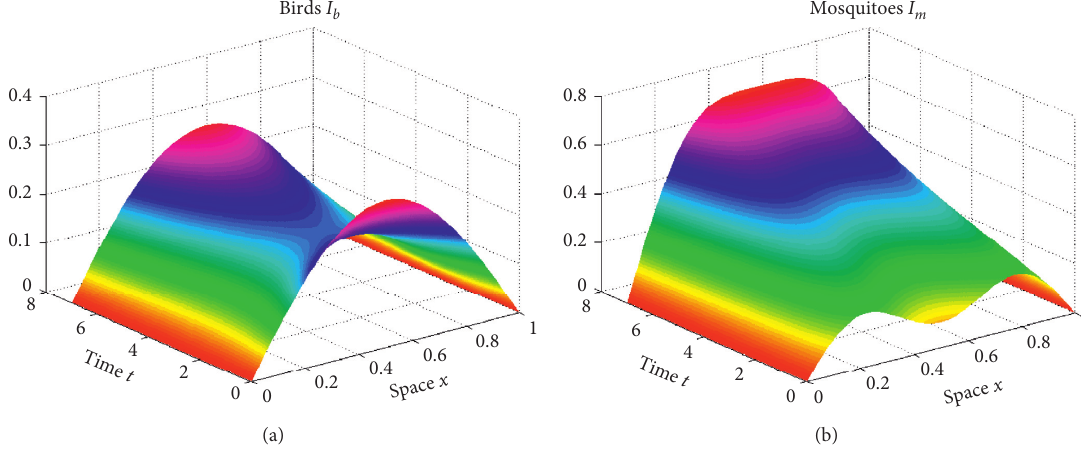
Figure 1: ρ ( t ) � 1. R ( 1 ) > 1, which implies that the solution tends to steady state in a fixed domain. 0